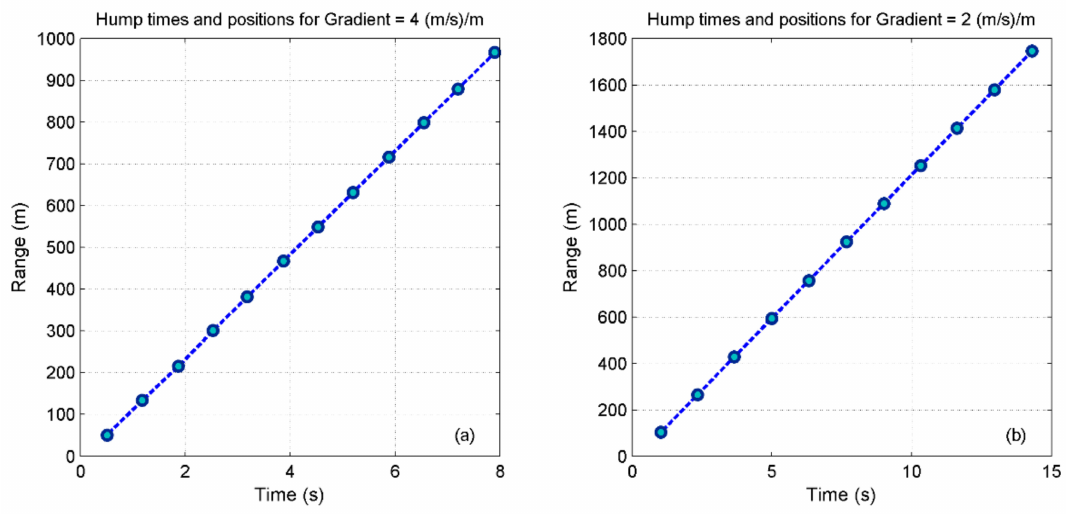
Figure 8. Times and positions for successive humps–compare gradients of g r = 4 (m/s)/m ( plot a ) and 2 (m/s)/m ( plot b ).